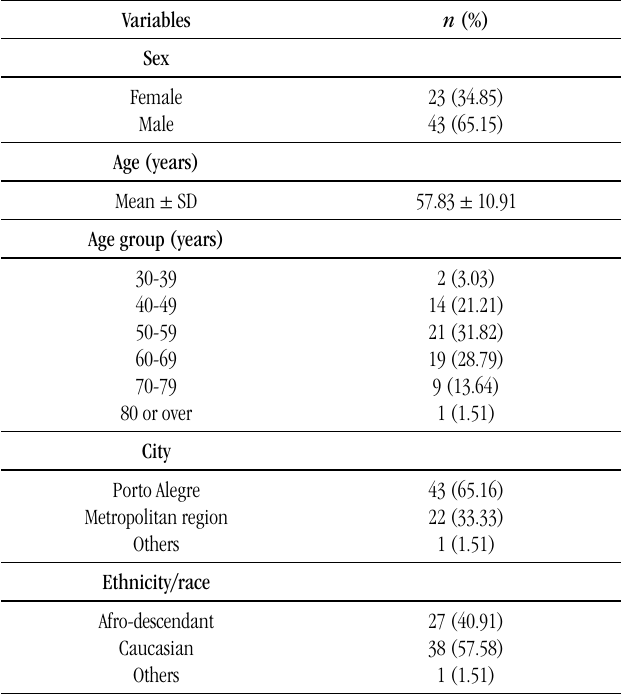
tABLE 2 – Absolute and relative distribution by sex, age group, city and ethnicity/race and mean age and SD of age for the group of 66 patients with hepatitis C